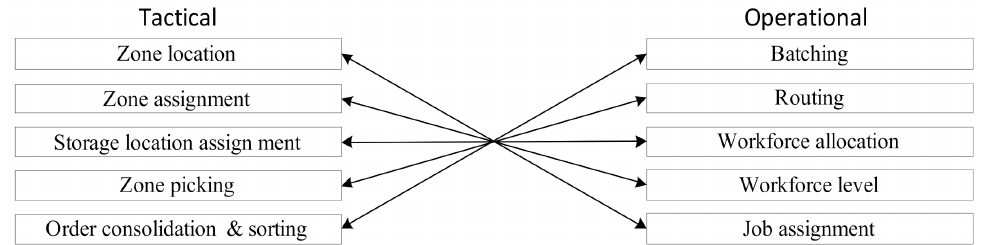
Figure 6. Order-picking process aspects (Van Gils et al. [2]).